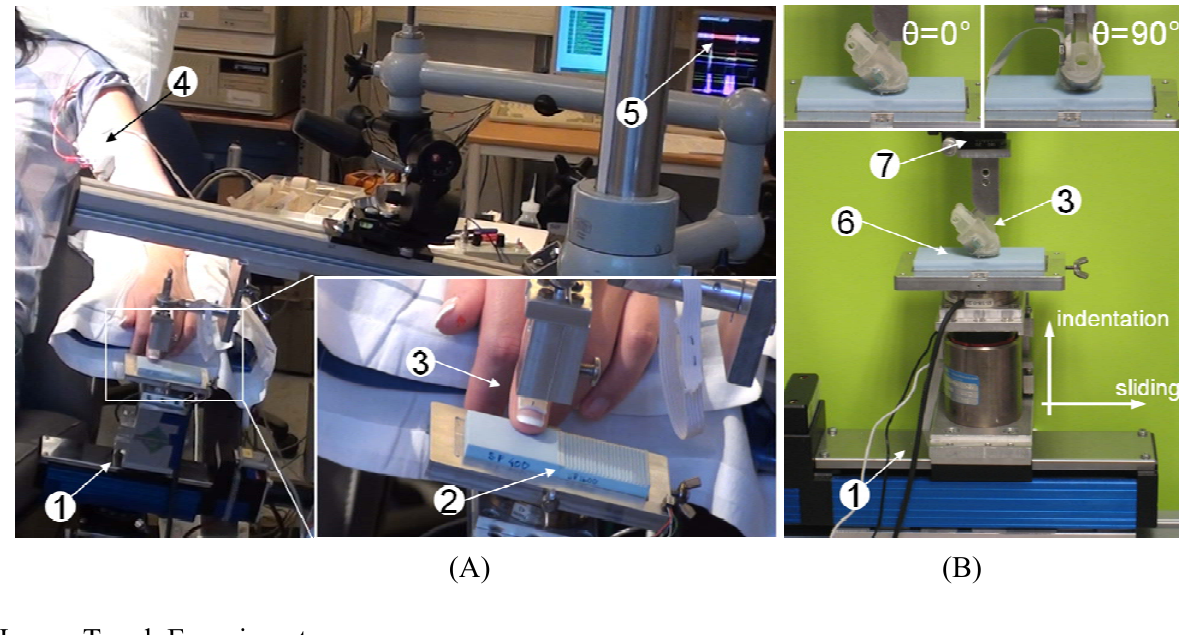
Figure 3. Experimental set-up in human ( Panel A ) and artificial ( Panel B ) touch experiments. 1: core mechatronic tactile stimulation platform; 2: pair of half-gratings; 3: human and biomimetic finger support; 4: first stage of microneurography electronics; 5: display with neural data for experiment monitoring; 6: single full-grating; 7: rotational stage with